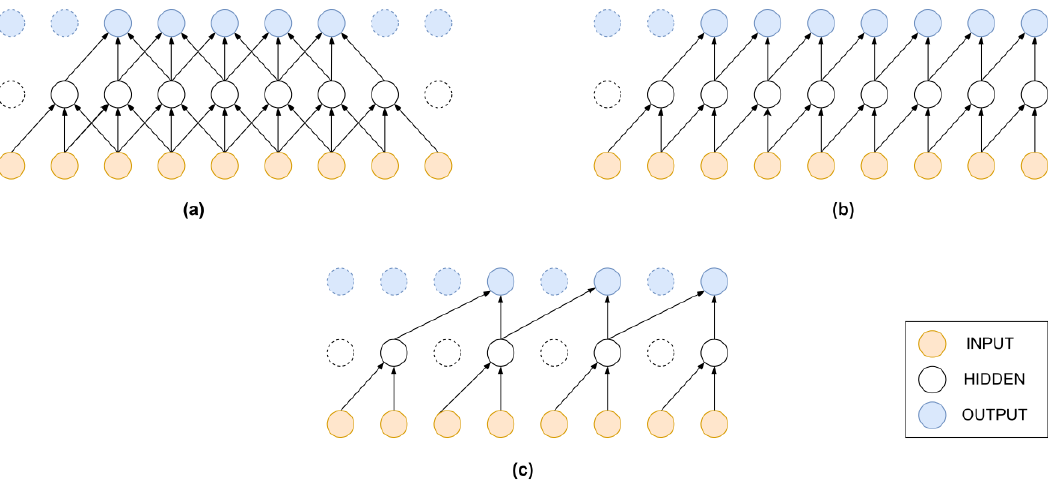
Figure 4. One-dimensional CNN structure with ( a ) standard convolution, ( b ) causal convolution, and ( c ) dilated causal